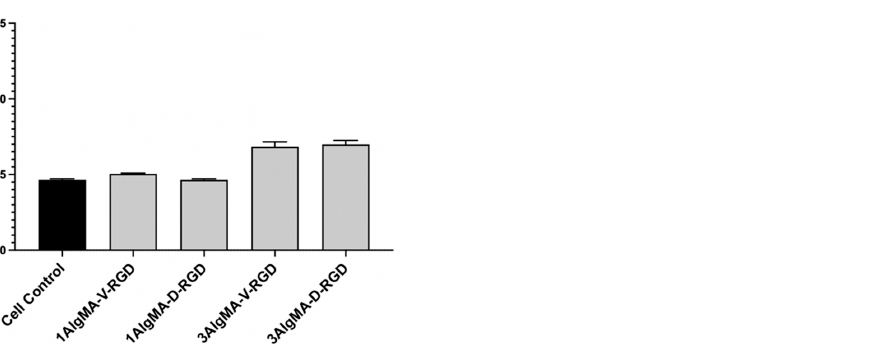
Figure 6. Qualitative fluorescent images of Calcein-AM stained C2C12 cells (bright green) indicated that the scaffolding materials supported cell adhesion and maintained cell viability after 24 h of culture in vitro. The visible-light crosslinked samples indicated higher cell densities compared to the dual-crosslinked samples within the 1 and 3% ( w / v ) AlgMA-v-RGD groups (scale bar = 1 mm).